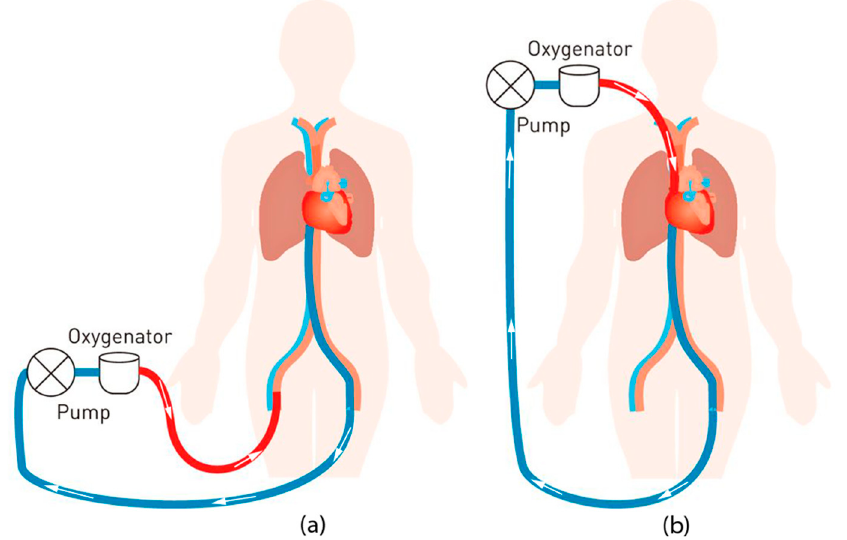
Figure 1. Illustration of the ECMO circuit. ( a ) Represents venous-arterial and ( b ) represents venous- venous setup. (Red is oxygenated blood while blue is deoxygenated blood).